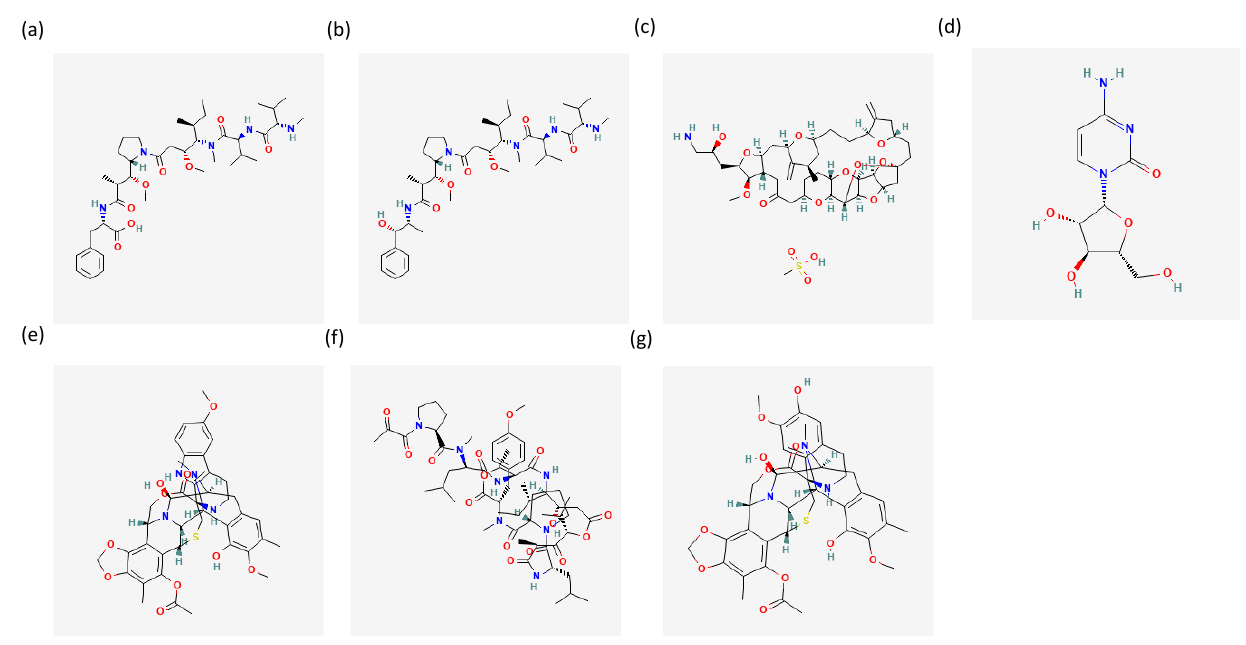
Figure 2. This figure shows chemical structures of ( a ) MMAF [28], ( b ) MMAE [29], ( c ) eribulin [30], ( d ) cytosine arabinoside [31], ( e ) lurbinectedin [32], ( f ) plitidepsin [33] and ( g ) trabectedin [34]. Chemical structures are retrieved from the public database PubChem [35]. Table 1. Approved marine-derived drugs currently on the market for cancer therapy (as reviewed in [36]). Abbreviations: BCMA for B-cell Maturation Antigen, Ab for antibody, MMAF for monomethylauristatin F, MMAE for monomethylauristatin E and eEF1A for eukaryotic translation